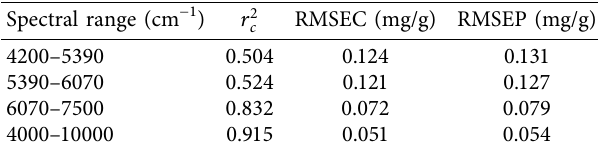
Table 3: Test results for the ranges of NIR spectroscopy. Spectral range (cm − 1 )